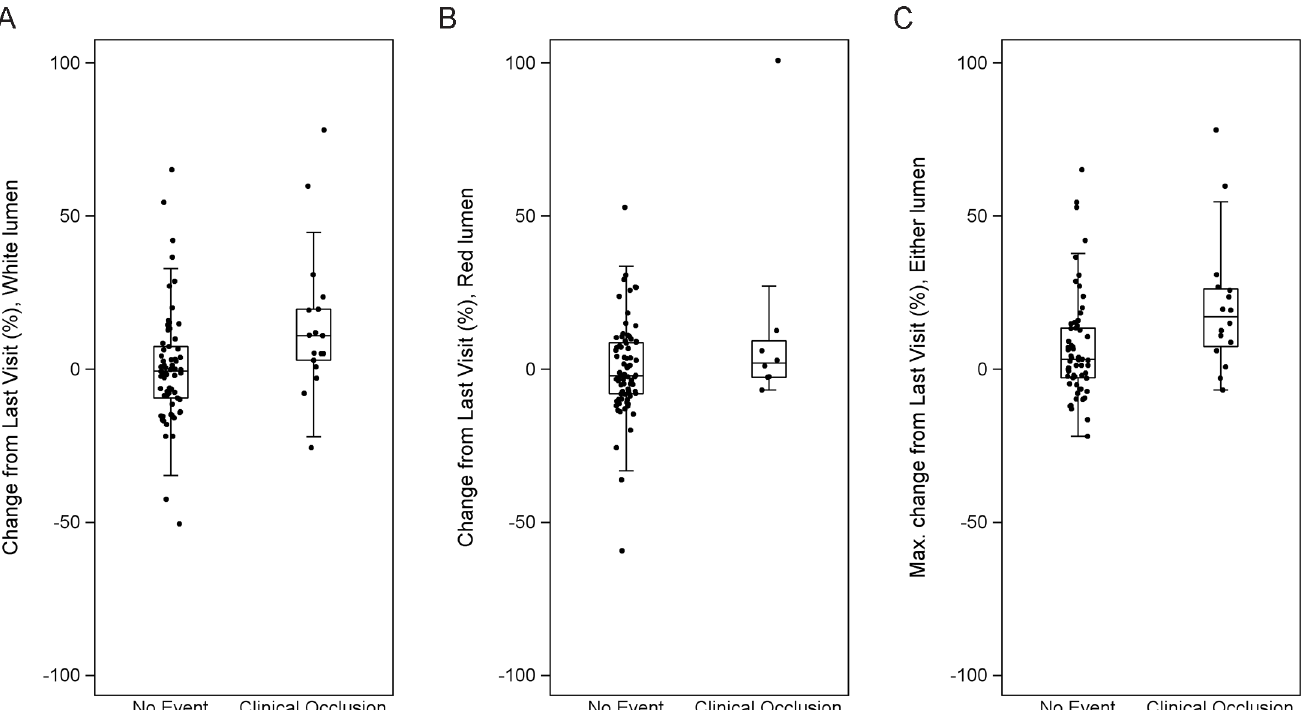
Fig 5. Scatter plot of catheter-resistance monitoring results. Results are stratified by whether a clinical occlusion occurred within 10 days. The changes in resistance from Last Visit are shown. (A) Change in resistance in the smaller white lumen only, (B) the red lumen only, or (C) maximal change in either lumen. Occlusion was frequently preceded by a detectable rise in resistance that was not clinically apparent.